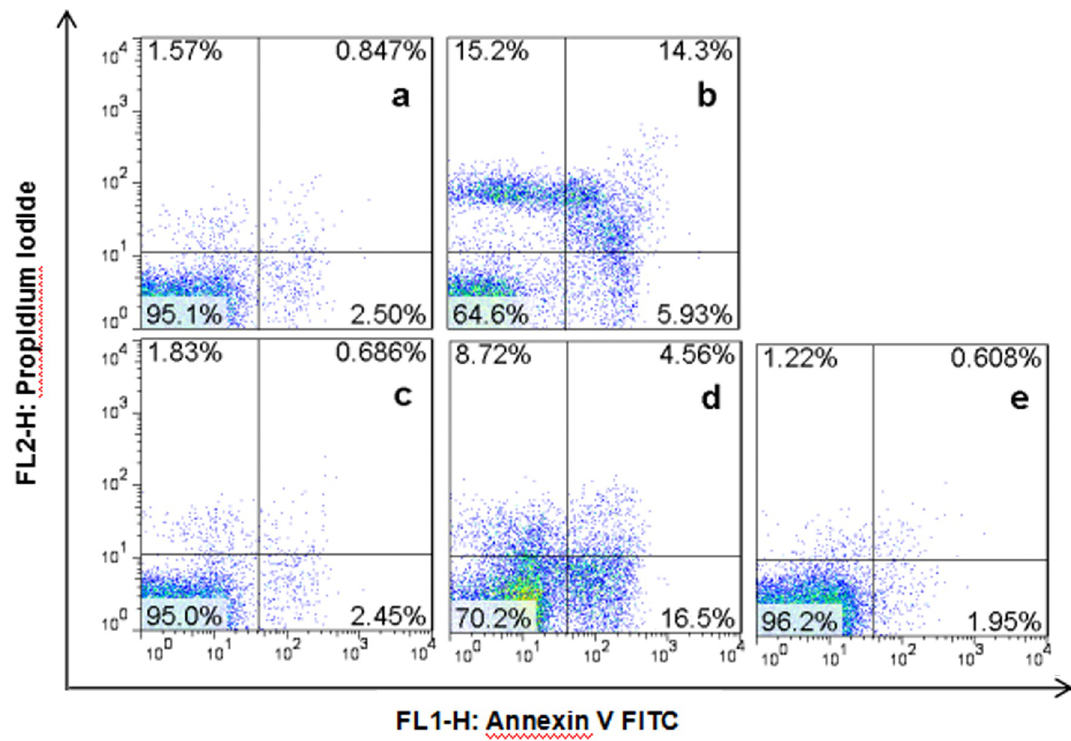
Fig 4. Effect of AgNPs on cell apoptosis of A . vinelandii . (a) nano-Ag 10 at a concentration of 2 mg/L; (b) nano-Ag 10 at a concentration of 10 mg/L; (c) nano- Ag50 at a concentration of 10 mg/L; (d) nano-Ag 50 at a concentration of 100 mg/L; (e) no AgNPs added. All treatments were exposed for 12